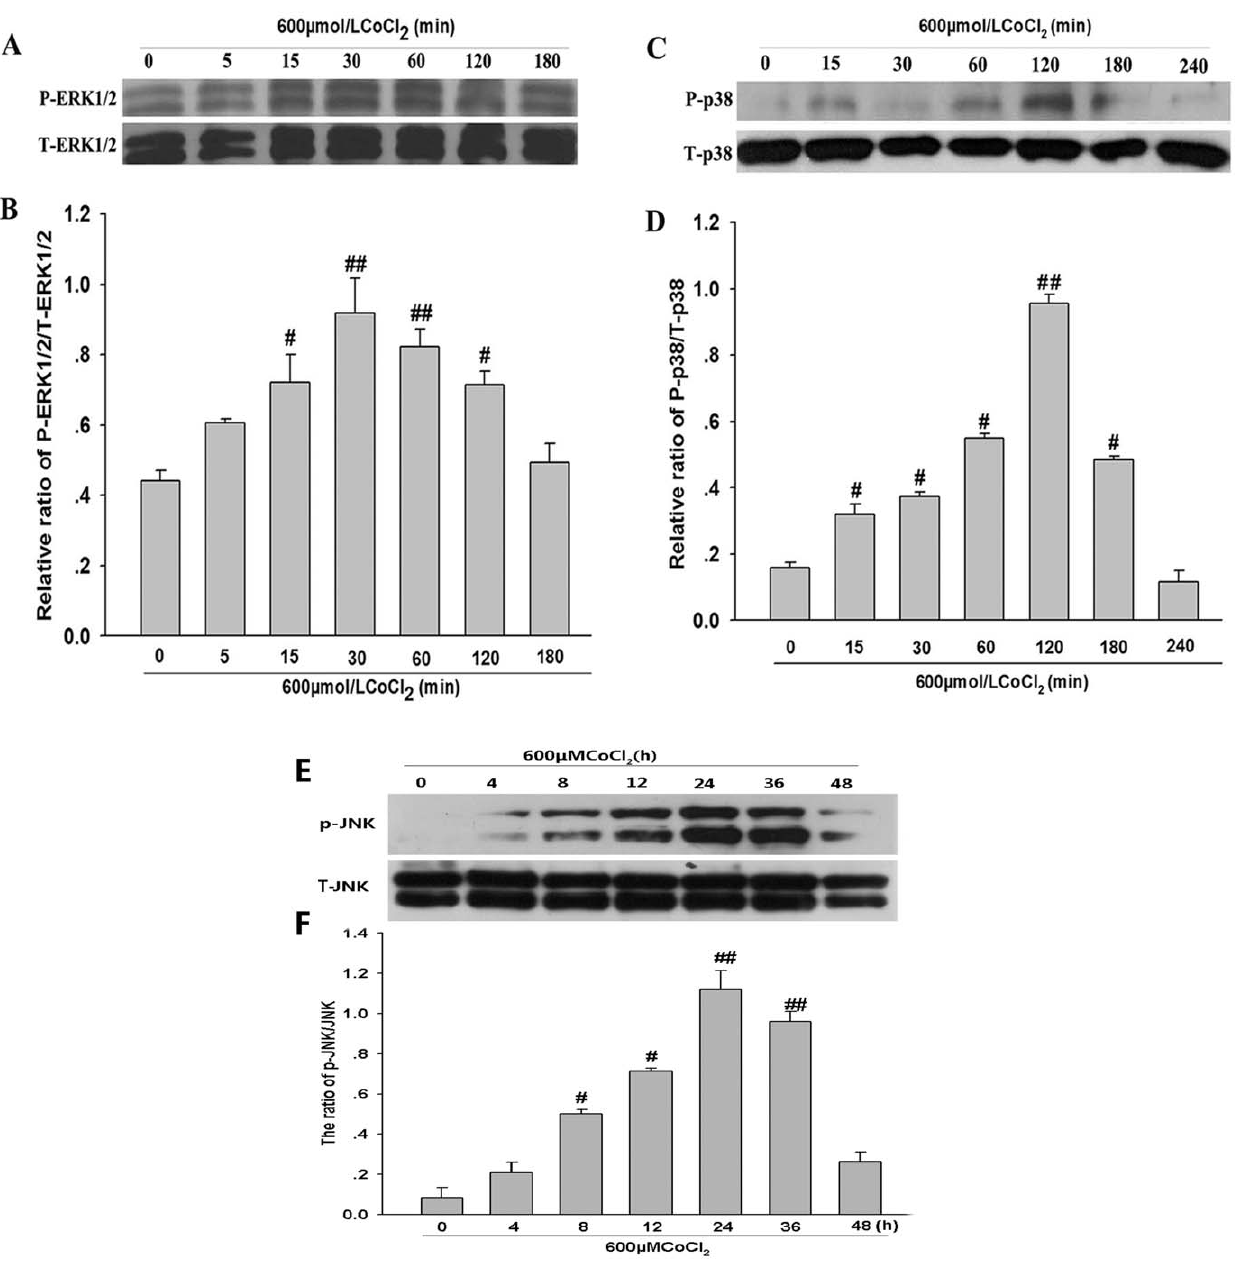
Figure 4. CoCl 2 -induced activation of ERK1/2, p38MAPK and JNK in PC12 cells. (A), (C) and (E) time course for the effects of CoCl 2 on phosphorylation of ERK1/2, p38MAPK and JNK, respectively. (B), (D) and (F) Denstiometric analysis for the results in (A), (C) and (E), respectively. Data are presented as the mean 6 SE (n=3). # P , 0.05, ## P , 0.01 compared to the control group (0min), respectively.